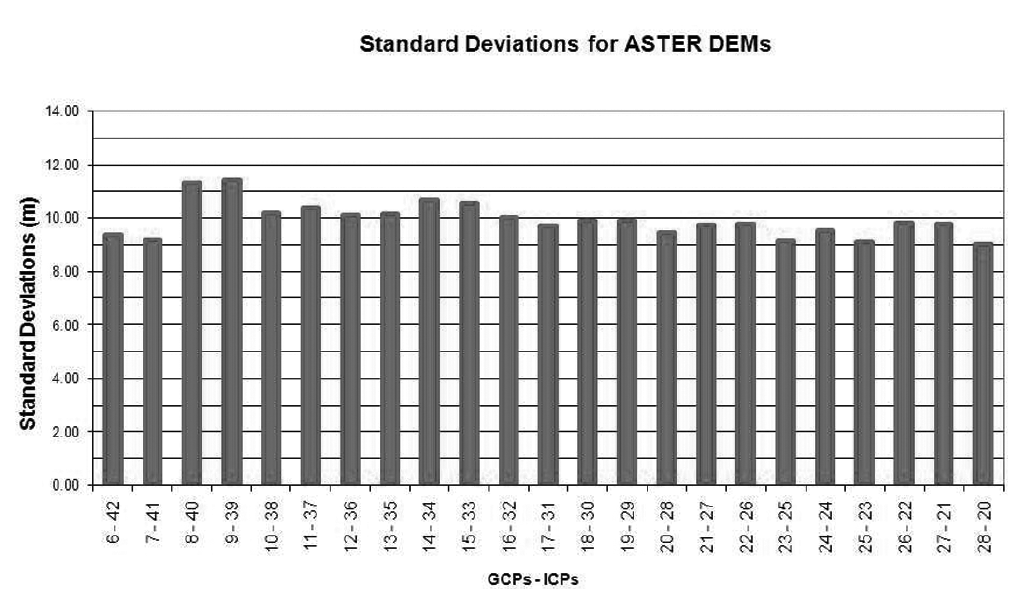
Fig. 4 – Distribution of Standard Deviations for ASTER DEMs considering the influence of the numbers of GCPs and ICPs.